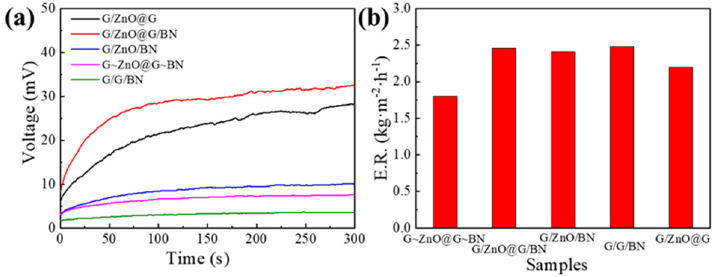
Figure 8. ( a ) Open circuit voltage and ( b ) SVG rate for different devices.